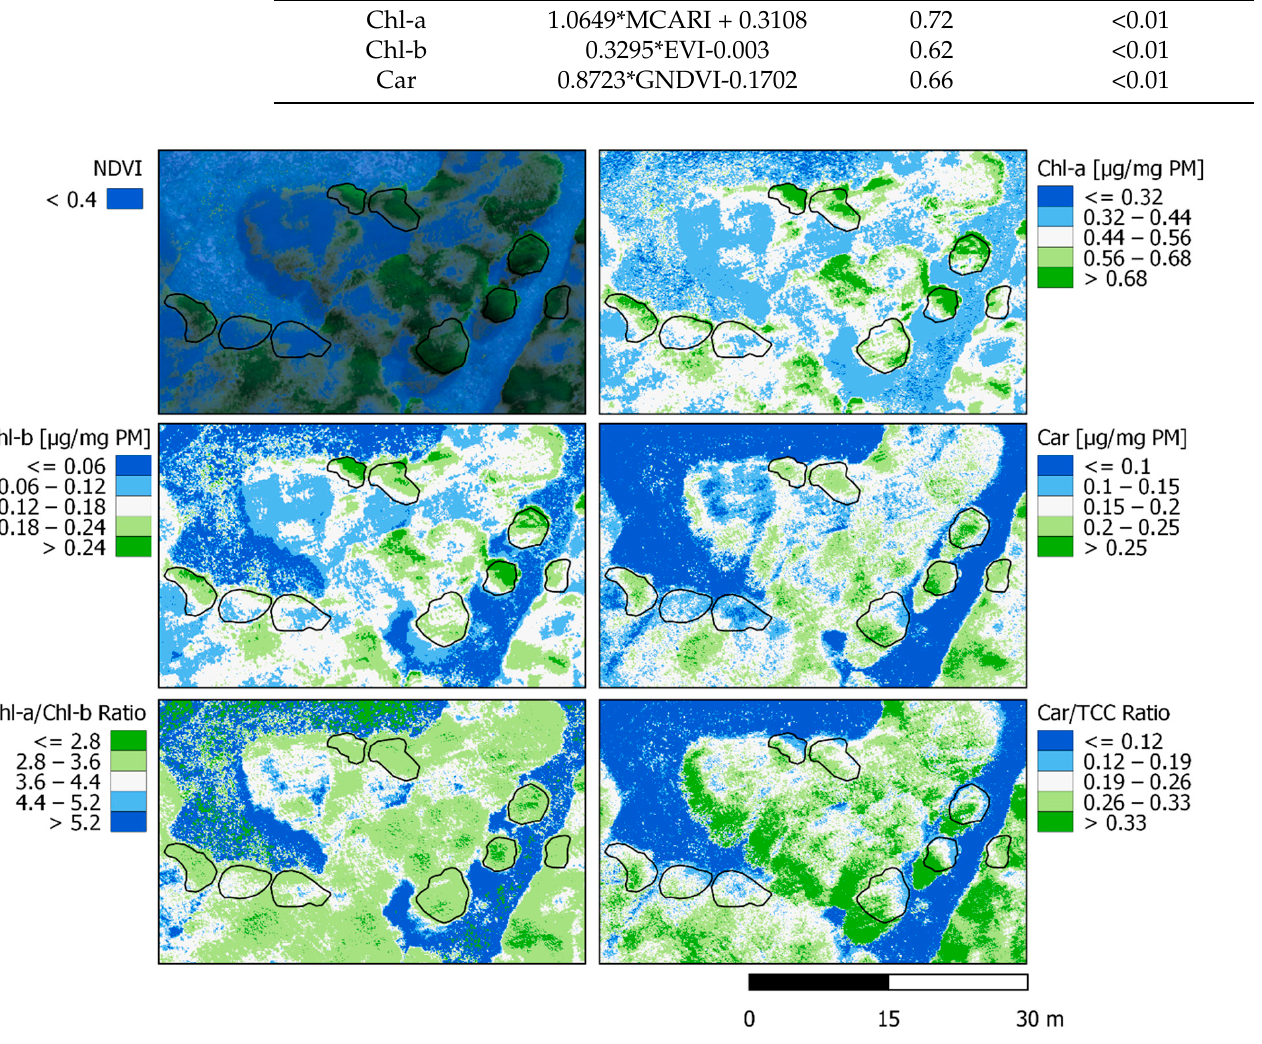
Figure 7. Spatialization of linear regressions obtained from the best indices for each pigment (Chlorophyll-a with MCARI, Chlorophyll-b with EVI, and Carotenoids with GNDVI). Ratios Chl-a/Chl-b and Car/TCC are also shown, together with the RGB multispectral composite and the green pixel selection for reference.